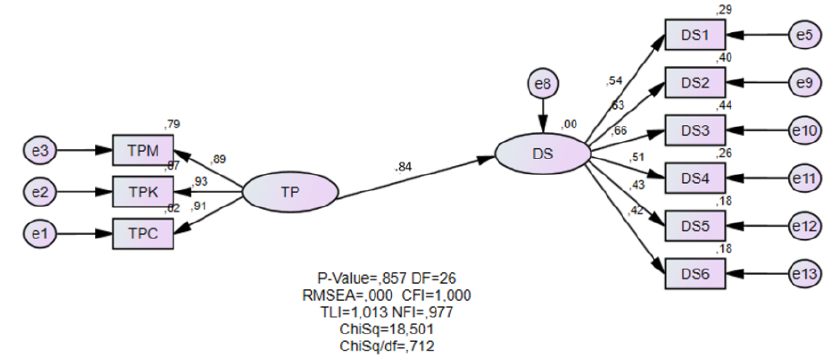
Figure 2: The Structural Analysis Between Perception and Lecturers